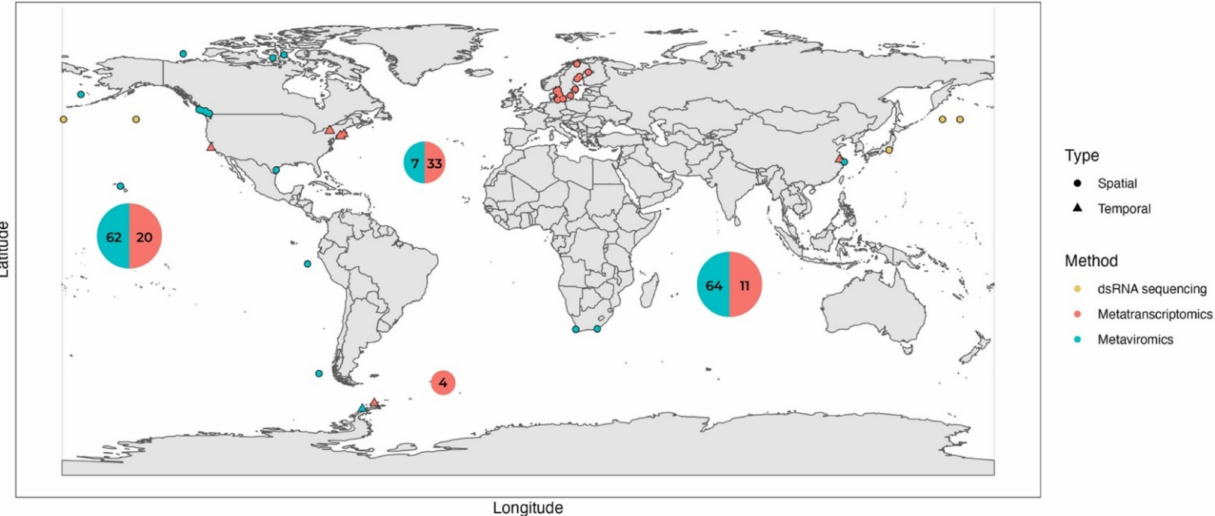
Figure 4. Geographic locations of aquatic metaviromic (blue), metatranscriptomic (coral), and dsRNA sequencing (yellow) studies focusing on RNA viruses reviewed in this paper. Spatially focused studies are represented with circles, and temporally focused studies are represented with triangles. Two global surveys with extensive geographic coverage, Dayang No. 1 cruises and Tara Oceans Expedition [51,57], are represented by large bubbles in each of the five oceans. The size of the bubble is proportional to the total number of samples collected from each ocean, with numbers of benthic virome samples from the Dayang No. 1 cruises [57] indicated in blue, and number of pelagic metatranscriptome samples from the Tara Oceans Expedition [51] in coral. Samples from the Mediterranean Sea were included in the counts of the Atlantic